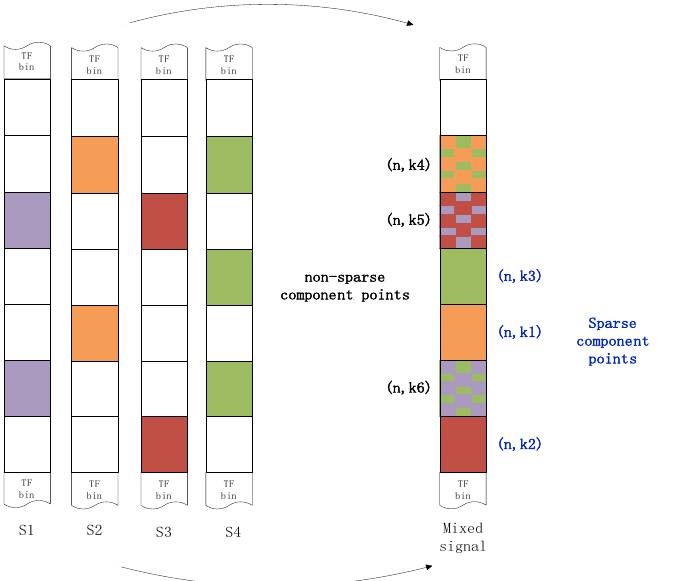
Figure 5. Schematic diagram for sparse and non-sparse component points. The rectangular boxes with a single color represent sparse component points; Rectangular boxes with multiple colors represent non-sparse component points.